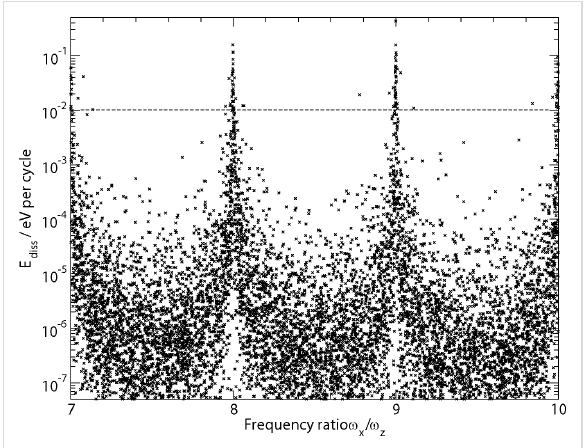
Figure 5: Dissipation rate depending on frequency ratio ω x / ω z for different systems. Dashed line indicates the lower bound of experimen- tally observed values. Dissipation rate is averaged over 300 cycles.